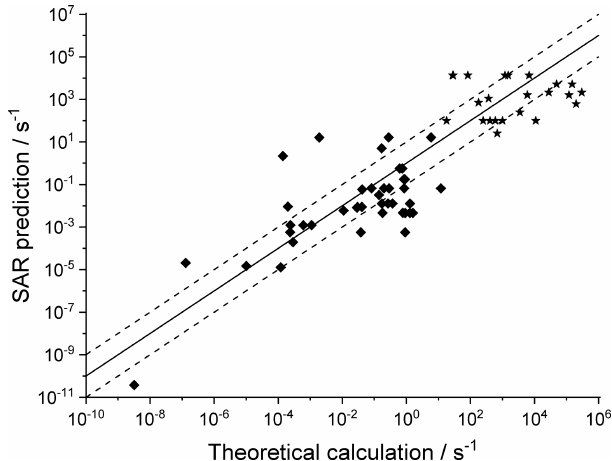
Figure 5. Literature theory-based k (298K) rate coefficients com- pared against the SAR predictions (see text for references) in multi- functionalized species with spectator substituents. The stars are (cid:113) OOH / OO H-scrambling reactions. The solid line shows 1 : 1 cor- respondence, with the dotted lines delineating an order of magni- tude of uncertainty